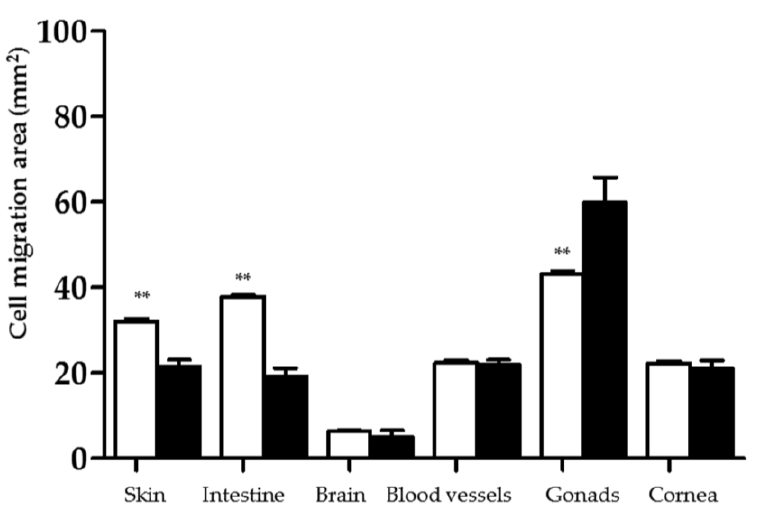
Figure 4. Cell migration assessment (mm 2 ) on PEO(5%)coHSAm(5%)fb(0.5%) IPNs (white) and Thermanox ® (black) after a week of culture. The surface of cell layers surrounding the explants was determined using ImageJ software on neutral red-stained sample pictures taken with a stereomicroscope fitted with a camera. Data were analyzed using Student’s t -test, ** p ≤ 0.001 compared to the Thermanox ® group.